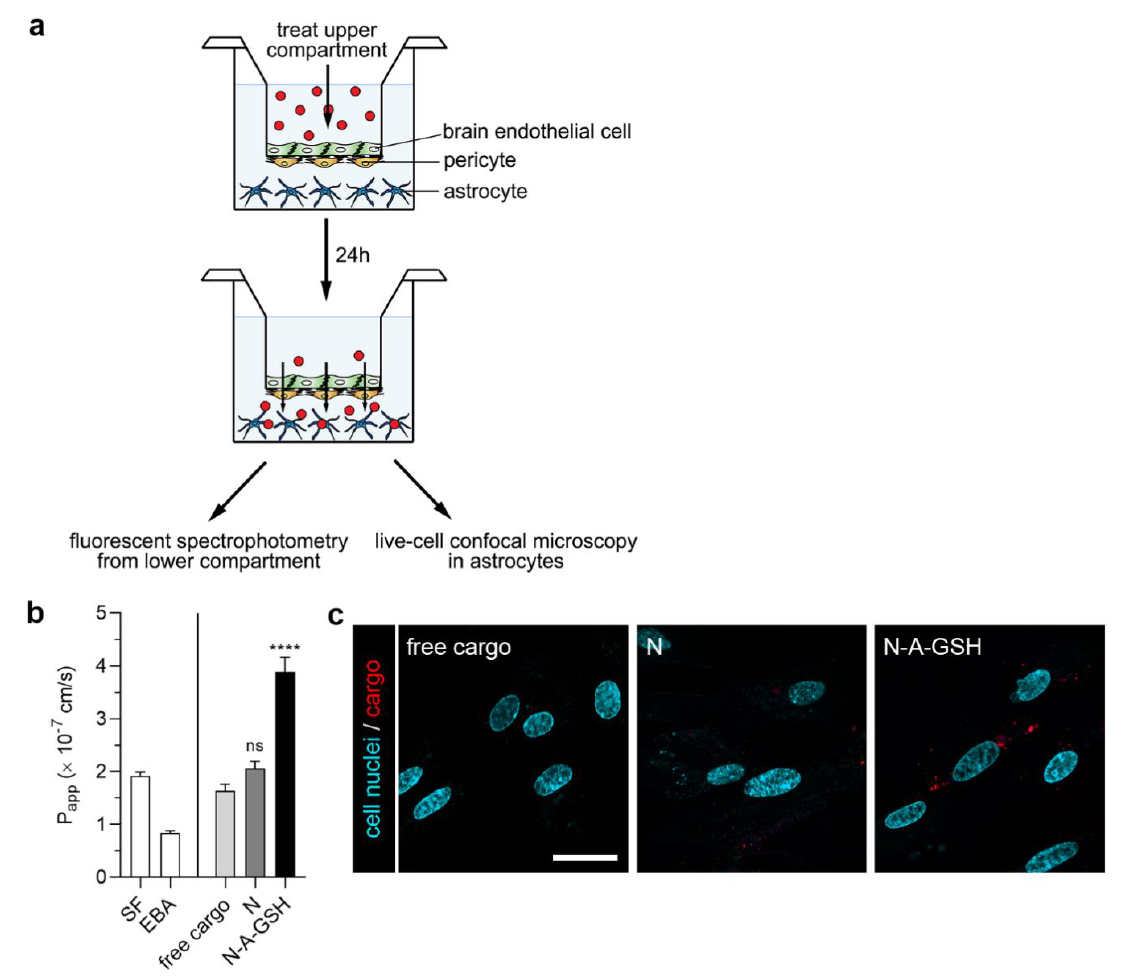
Figure 8. ( a ) Schematic drawing of the BBB co-culture model and the workflow of the experiment. ( b ) 24-hour permeability of mCherry cargo across the BBB model. P app : apparent permeability coefficient; SF: sodium fluorescein; EBA: Evans blue-albumin complex; free cargo: mCherry not loaded in